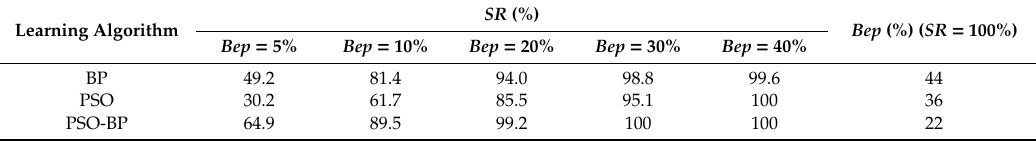
Table 5. Values of the SR for the developed models.